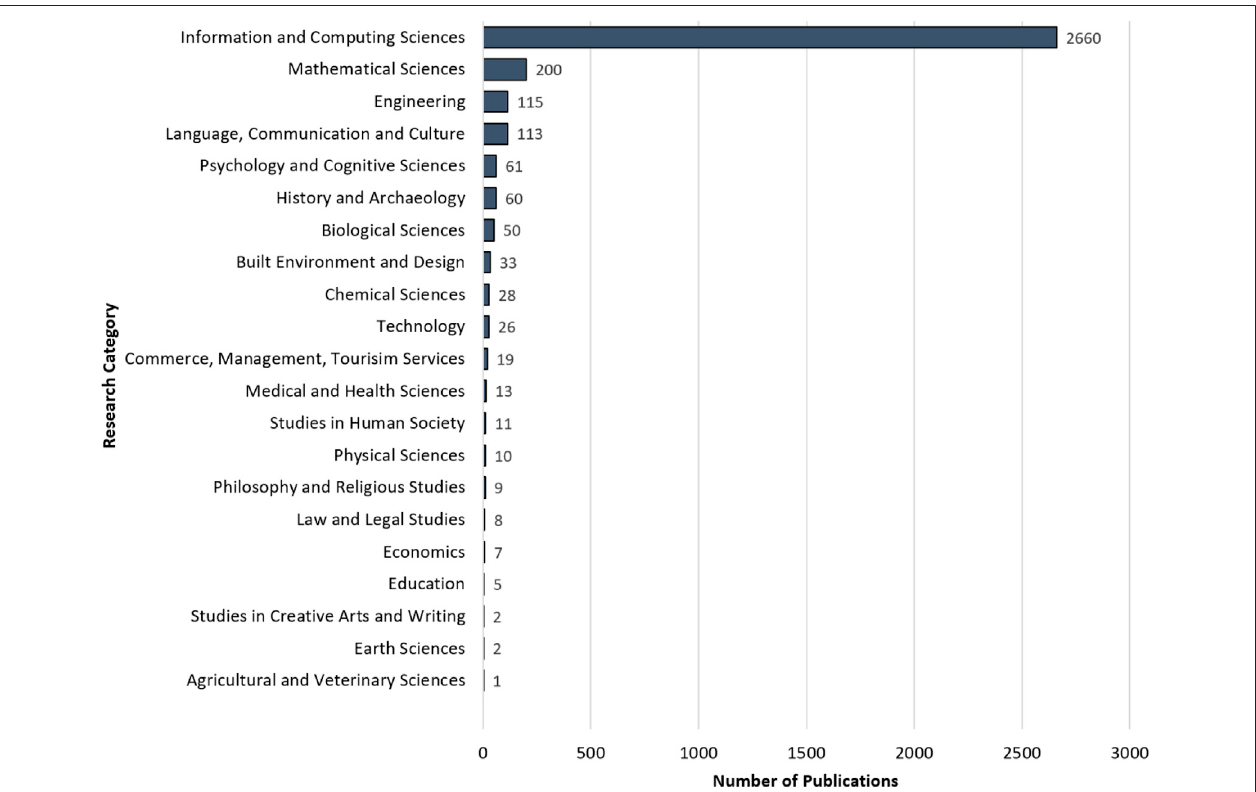
FIGURE 3 | An ordered grouped list of publications according to their research categories. These results were collected by searching Scopus 3 for the keywords Graph Rewriting , Engineering , and Design